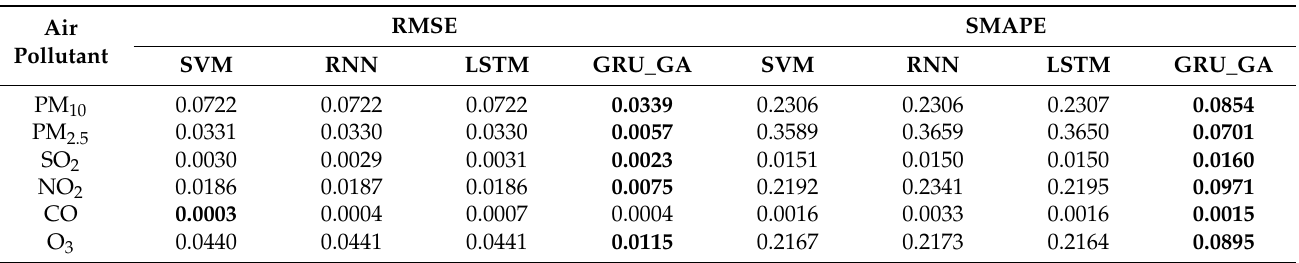
Table 14. The prediction results of GRU_GA compared with other air-quality-prediction methods with Dataset 2.